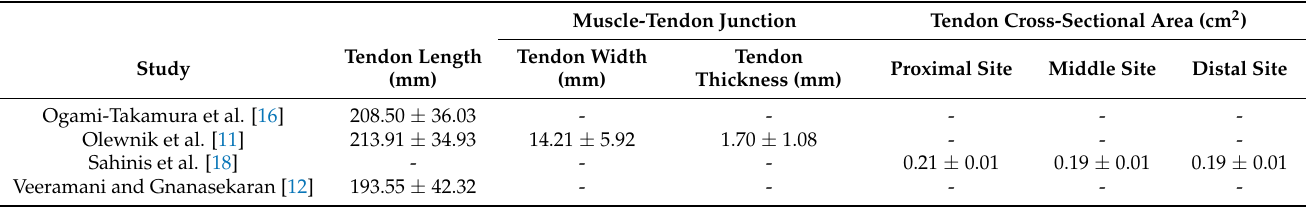
Table 5. Results of architectural data for the tendon/aponeurosis of tensor of vastus